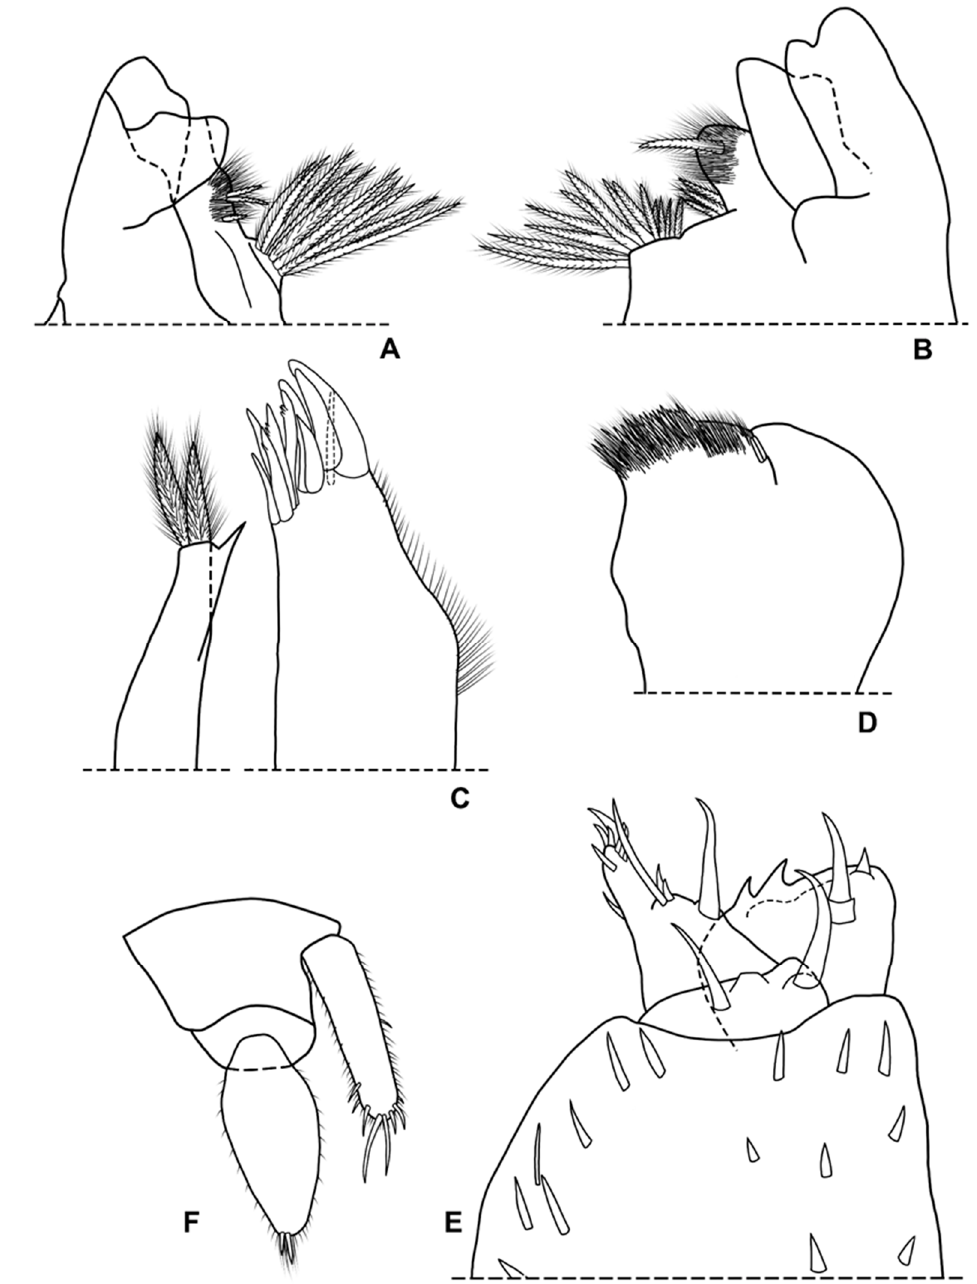
Figure 11. Porcellio incavatus sp. n., paratype ♂ from Santo Stefano d’Aveto. ( A ) Left mandible. ( B ) Right mandible. ( C ) Maxillula. ( D ) Maxilla. ( E ) Maxilliped. ( F ) Left uropod.